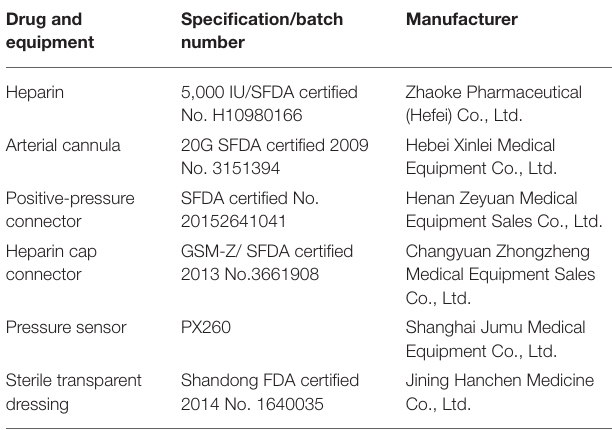
TABLE 2 | Statistics of drugs and